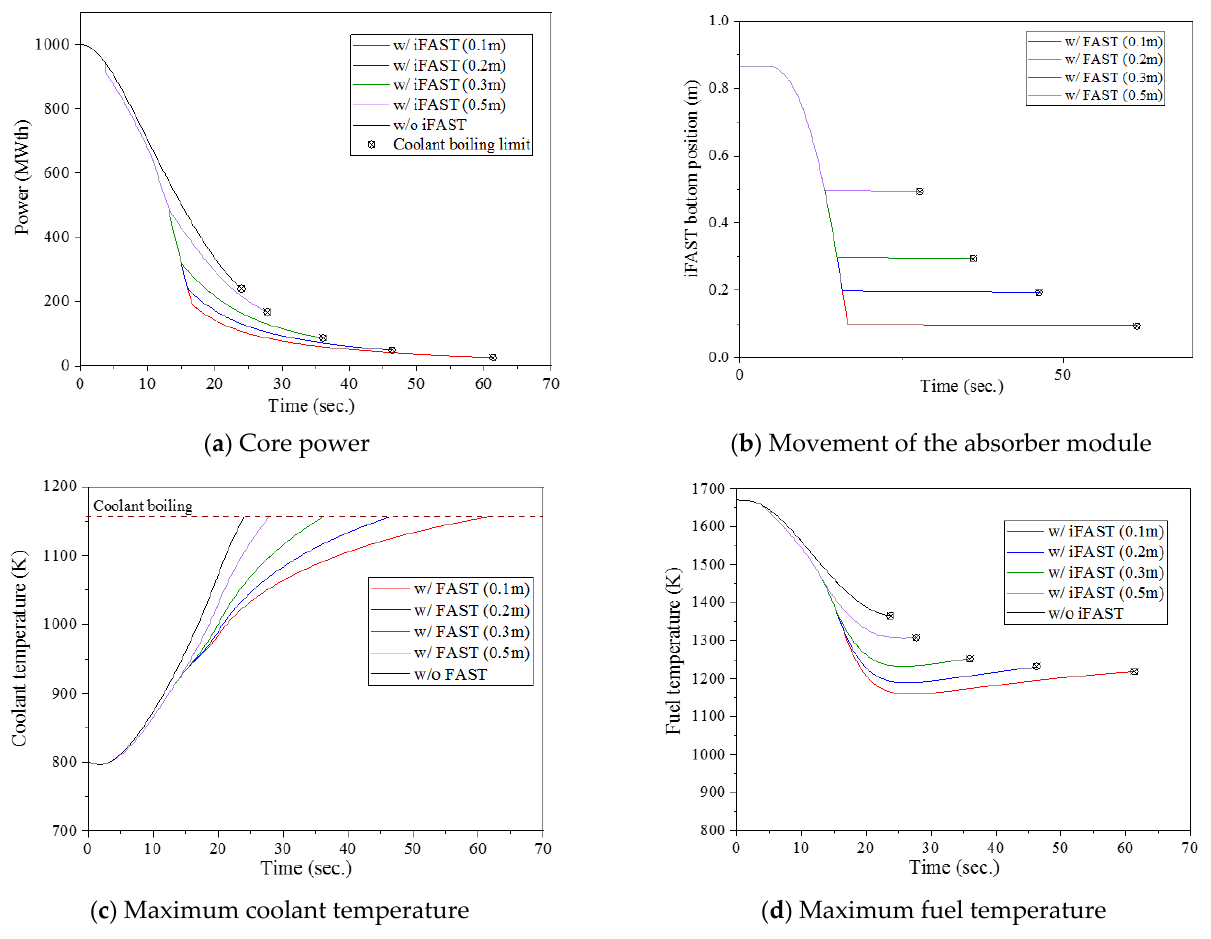
Figure 13. Unprotected loss of heat sink in ABR reactor and 1$ maximum iFAST worth